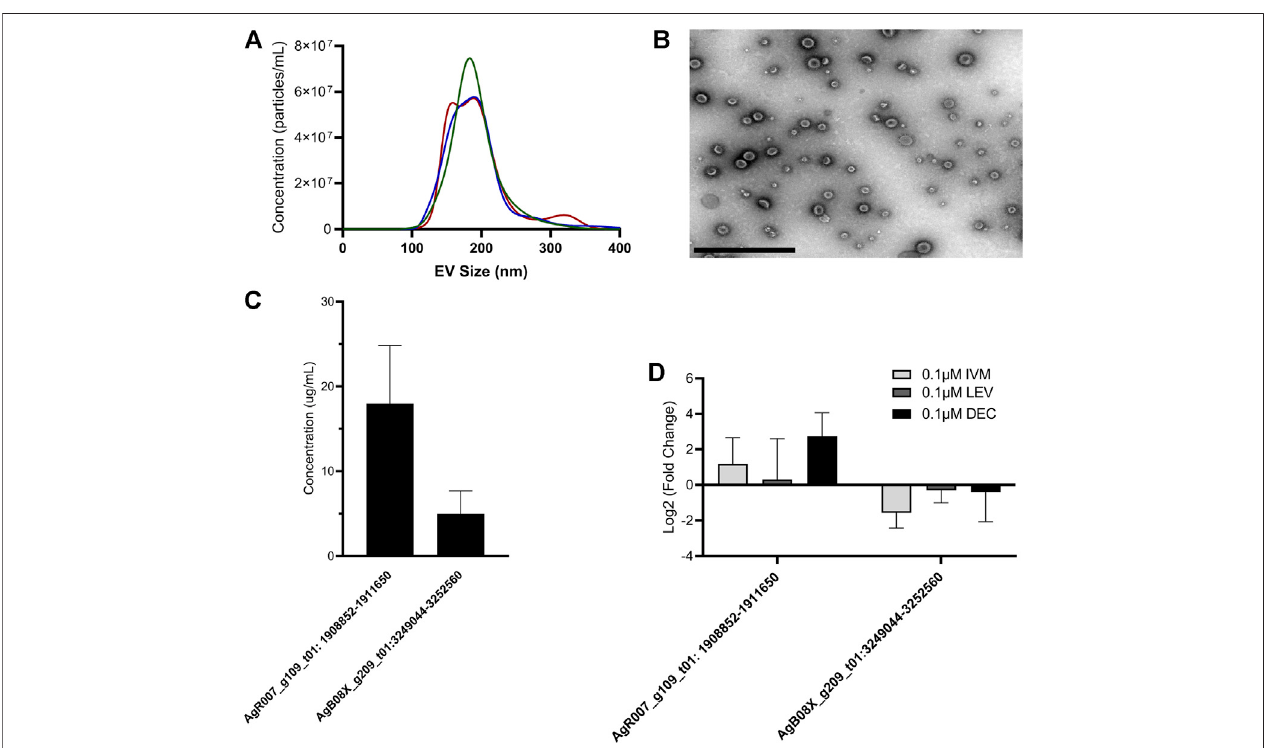
FIGURE 5 | circRNA expression from Ascaris suum extracellular vesicles (EVs) is unaffected by anthelminthic drug treatment. (A) Ascaris EVs were isolated using differential ultracentrifugation and nanoparticle tracking analysis (NTA) was used size and quantify EV population. Mean EV size was 194 nm. Size pro fi le for three independent EV isolations is shown. (B) Representative electron micrograph showing A. suum EV population. Scale bar 1 µm. (C) circRNA expression levels in EVs isolated from untreated A. suum was determined using RT-qPCR. Only two of the six circRNAs from Figure 4A were detected in A. suum EVs with accurate reproducibility. N = 3 (minimum), Mean ± SEM, p ≤ 0.05 (D) circRNA expression in EVs was unaffected by 24 h treatment of parental parasites with therapeutically relevant doses of the anthelmintic drugs ivermectin (IVM), diethylcarbamazine (DEC), or levamisole (LEV). circRNA expression in EVs was normalized to EVs secreted by untreated control (N = 3 minimum, Mean ± SEM, p ≤ 0.05).